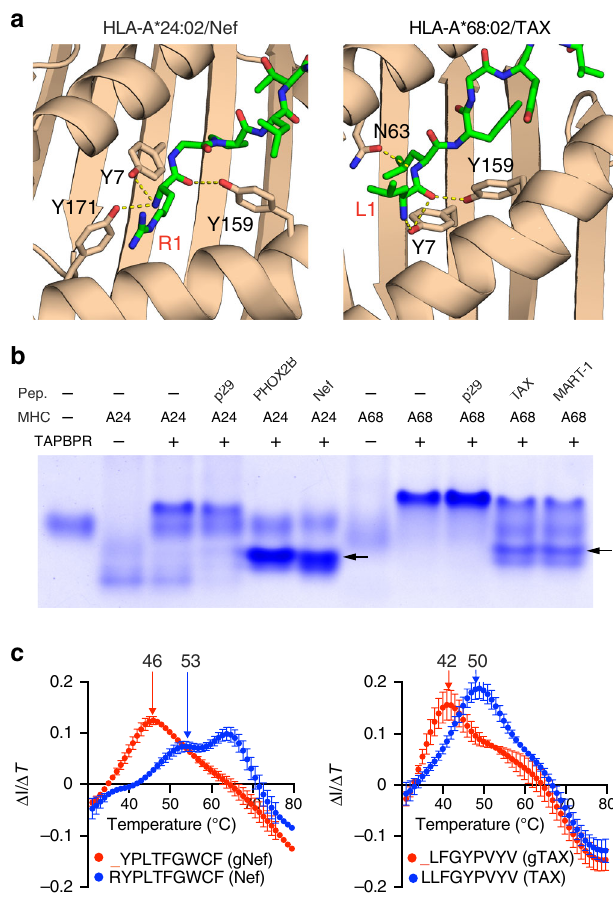
Fig. 4 TAPBPR-mediated peptide exchange on HLA-A*24:02 and HLA- A*68:02. a Structure-based design of goldilocks peptides: analysis of A- pocket hydrogen bonds observed in the X-ray structure of HLA-A*24:02/ Nef 134-10 (RYPLTFGWCF) and homology-based model of HLA-A*28:02/ TAX (LLFGYPVYV). Peptide residues are labelled in red, A-pocket